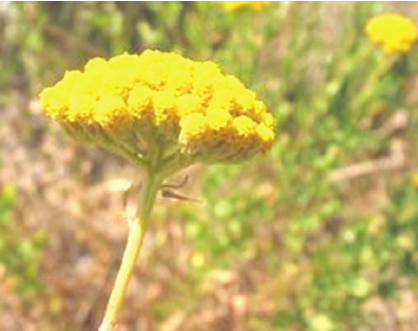
F 2: UV-Vis absorption spectra for CdO